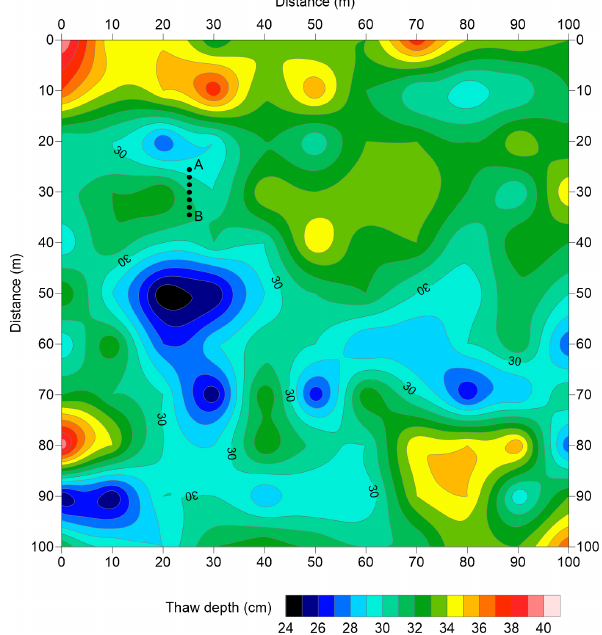
Figure 5. Spatial distribution of thaw depth measured at the grid nodes across the study area in January 2010. The location of the A-ERT transect is delineated with the black dotted line